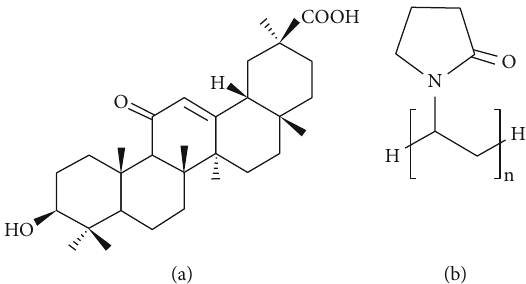
Figure 1: Chemical structure of glycyrrhetinic acid (a) and polyvinylpyrrolidone